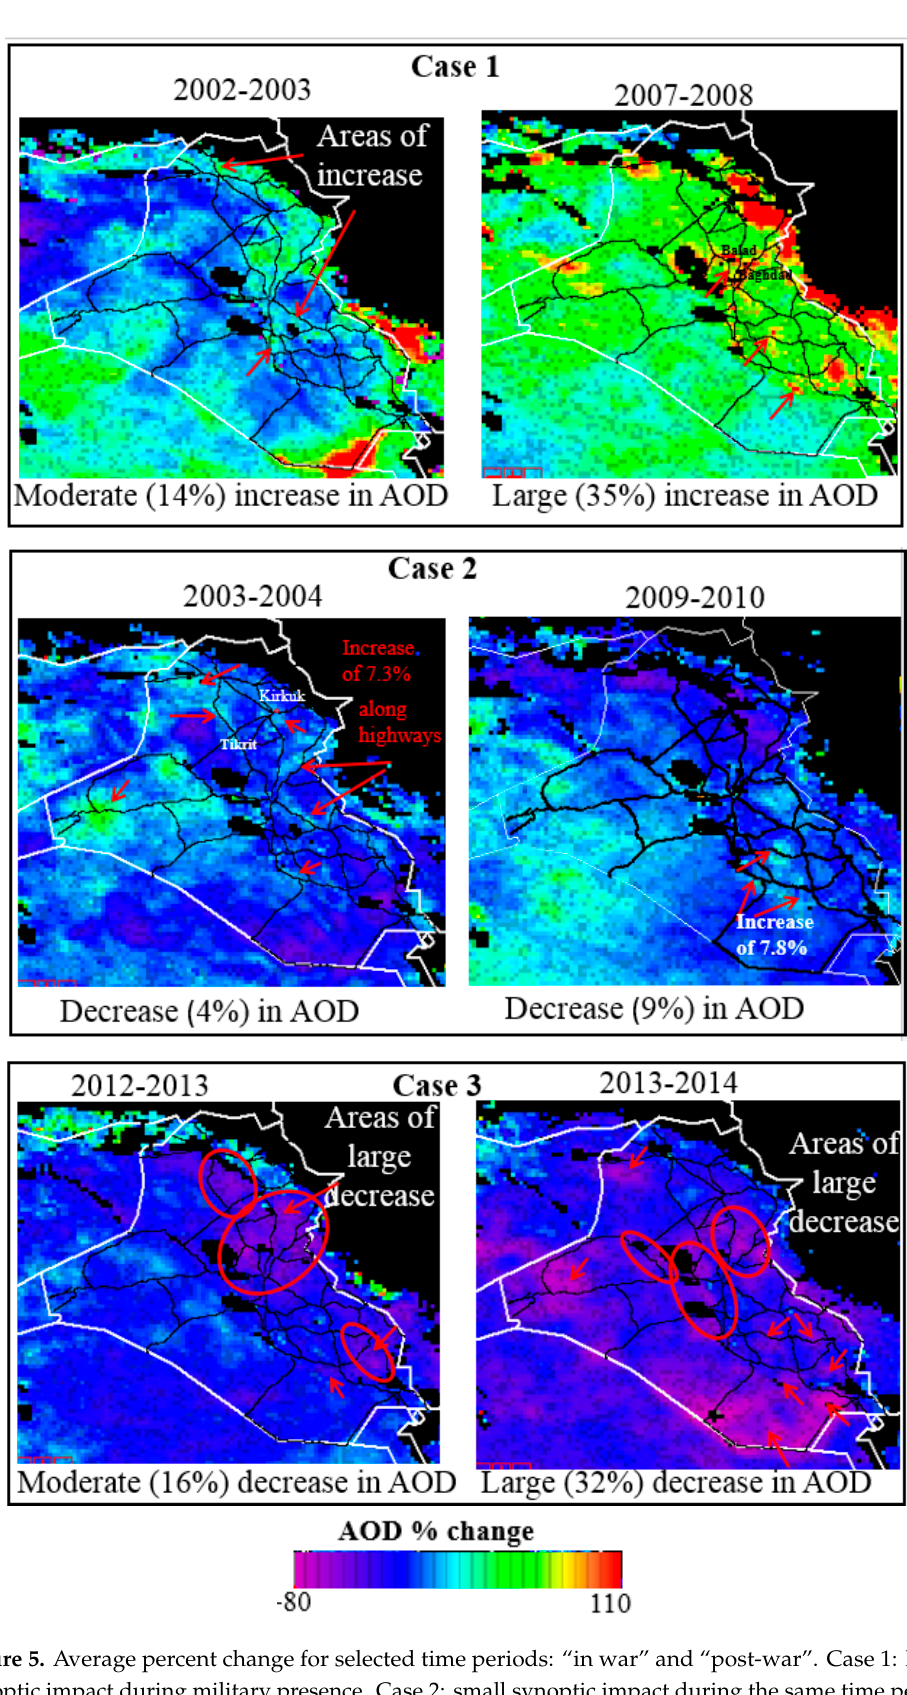
Figure 5. Average percent change for selected time periods: “in war” and “post-war”. Case 1: large synoptic impact during military presence. Case 2: small synoptic impact during the same time period for comparison. Case 3: “post-war” reference showing a general decrease in AOD.